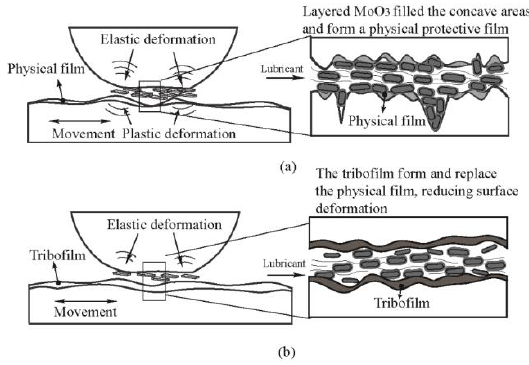
Figure 8. Schematic diagrams of the formations of ( a ) the physical film and ( b ) the tribofilm.